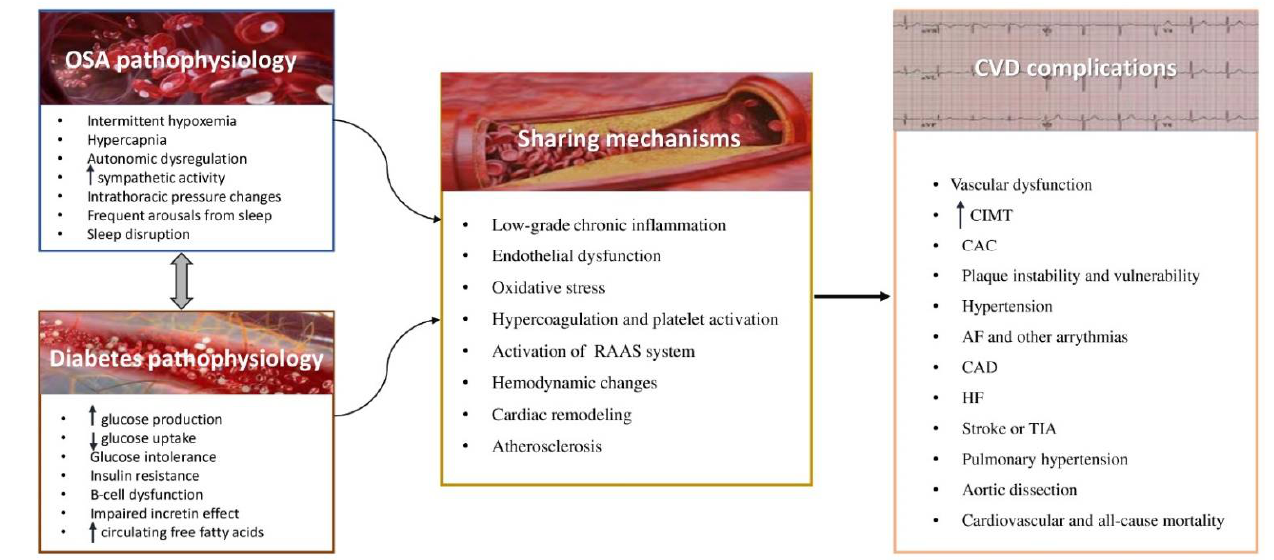
Figure 1. OSA and diabetes sharing pathophysiological mechanisms leading to CVD. OSA: ob- structive sleep apnea. CVD: cardiovascular disease, RAAS: renin- angiotensin aldosterone system, CIMT: carotid intima media thickness, CAC: coronary artery calcification, AF: atrial fibrillation, CAD: coronary artery disease, HF: heart failure, TIA: transient ischemic attack.